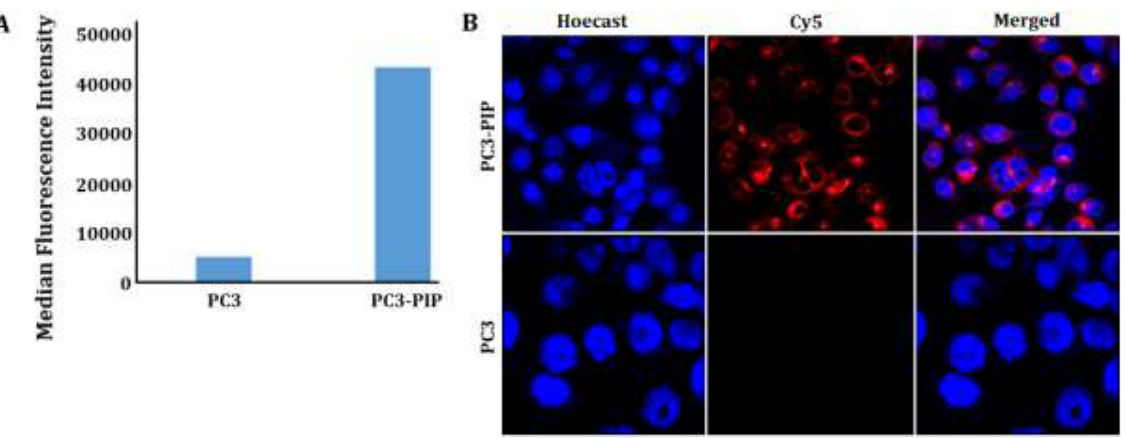
Figure 4. In vitro binding specificity and internalization studies of azide-modified J591-scFv conjugated into Cy5-labelled DBCO. A) Flow cytometry assays showed that the scFv dye conjugates specifically binds into PSMA positive prostate cancer cells (PC3-PIP) and not into PSMA negative prostate cancer cells (PC3). B) Immunofluorescence analyses also showed the specificity of scFv dye conjugate in PSMA expressing prostate cancer cells (PC3-PIP).